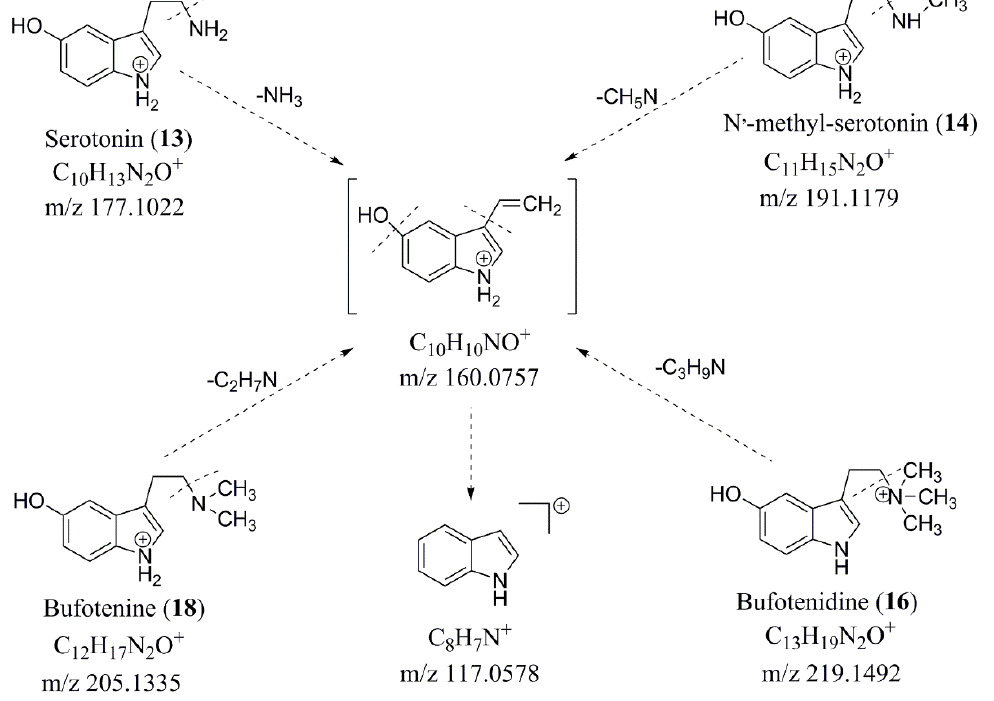
Figure 4. Diagnostic MS / MS fragmentation in serotonin (5-HT) and its derivatives.